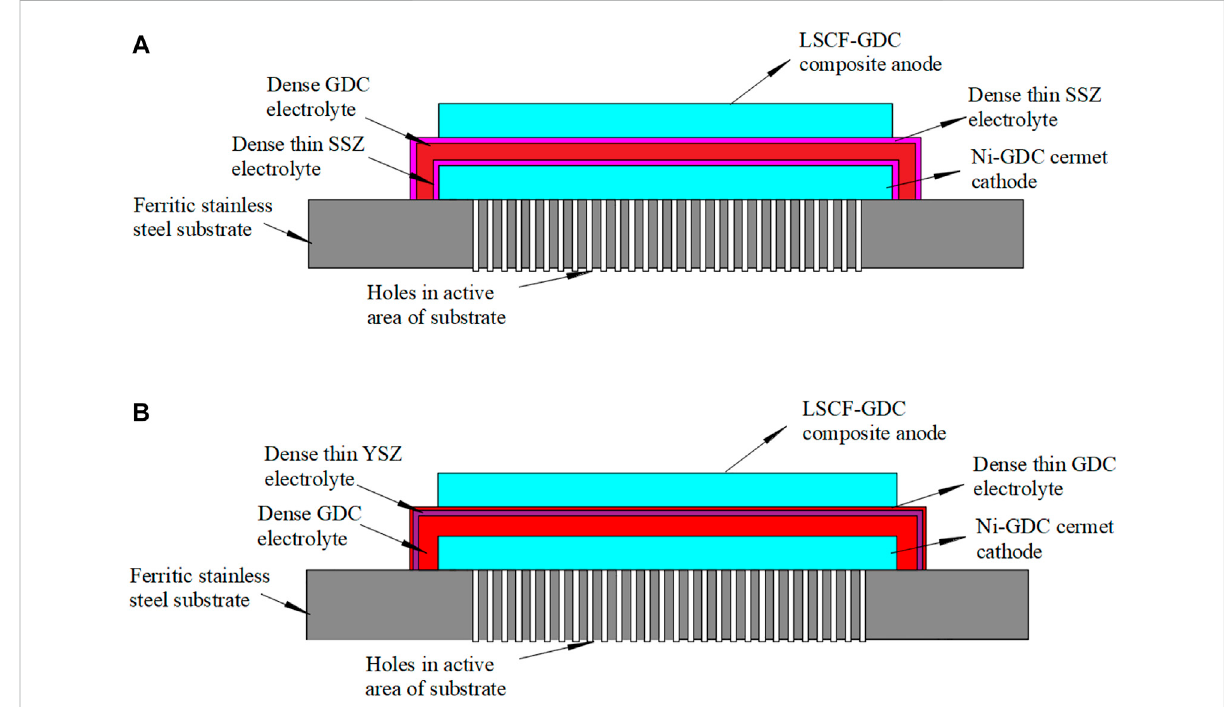
FIGURE 1 Two different designs of MS-SOEC: (A) 10Sc1CeSZ|GDC|10Sc1CeSZ multilayer electrolyte; (B) GDC|YSZ|GDC multilayer